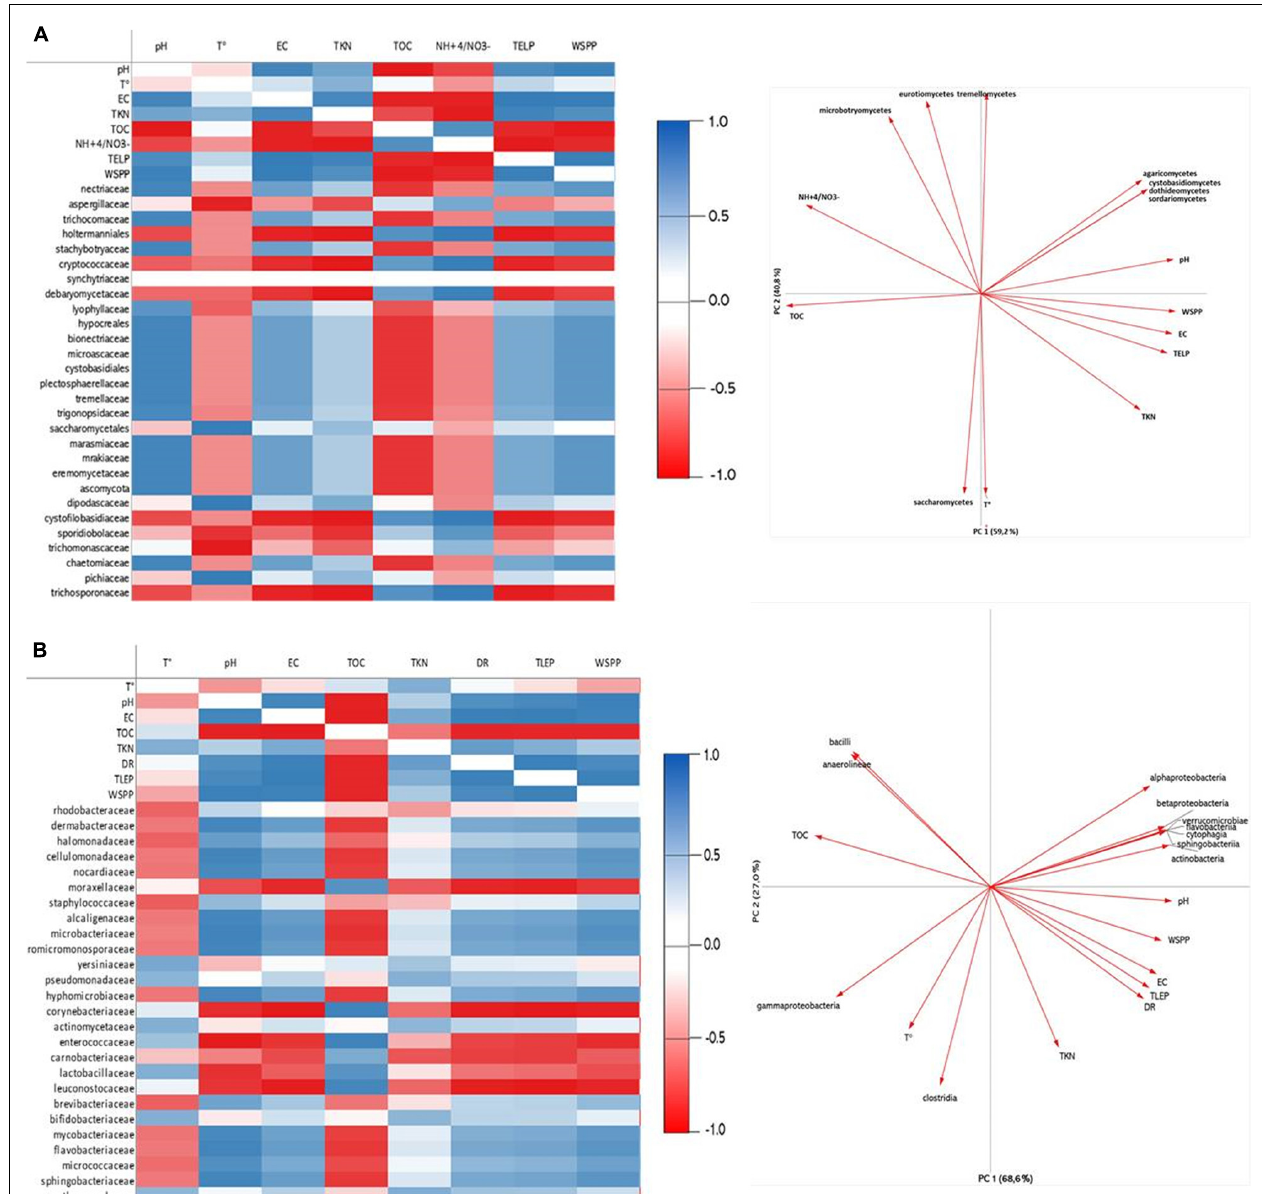
FIGURE 5 | Correlation heatmap and Principal Component Analysis (PCA) of the main parameters during composting treatment: TOC, Total organic carbon; K, potassium; Mn, Manganese; Phenols; TD, Decomposition rate; pH; Ca, Calcium with Fungi (A) and Bacteria (B) genera diversity.